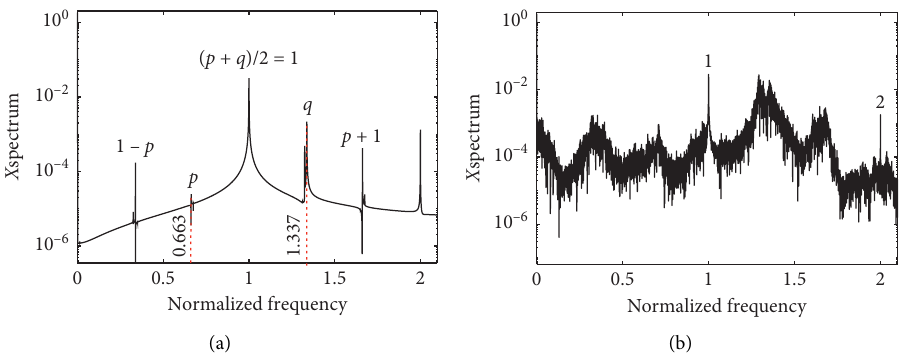
Figure 9: Power spectra of X ( τ ) of (a) quasiperiodic and (b) chaos motions of X ( τ ) for δ